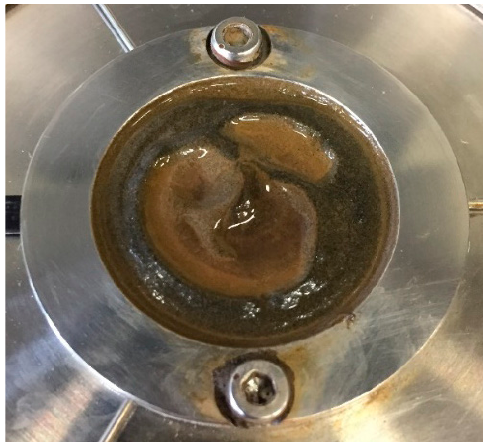
Figure 8. Upper surface of the cementitious paste (0.4_3%MNPs) after rheological tests.